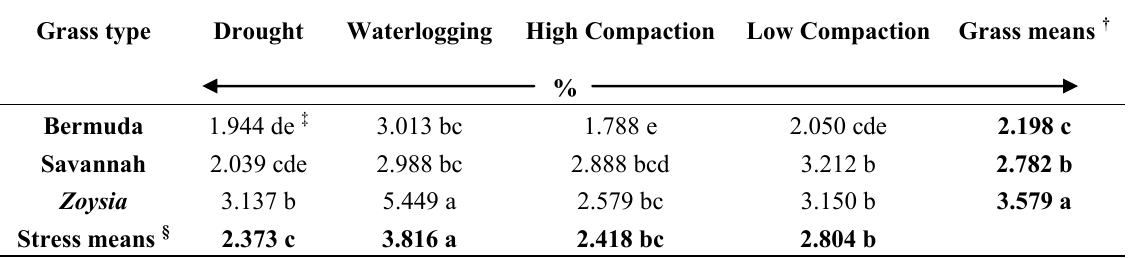
Table 9. Root zone NCPS for three turfgrasses affected by applied